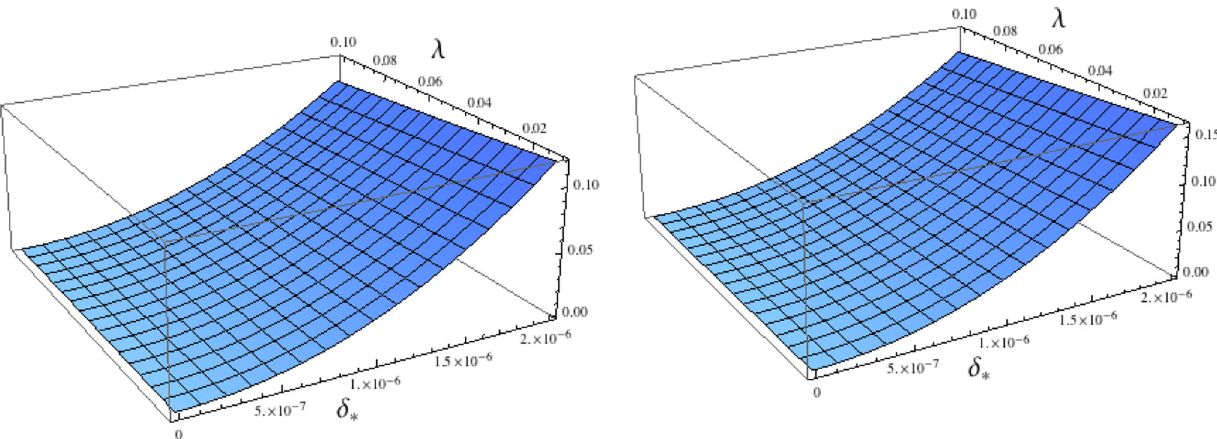
Fig. 9 Figures show the behavior of ˜ c 1 against δ (cid:25) and λ given by Eq. (4.47). A vertical axis represents values of ˜ c 1 . For the plots we have used N = 60 (left panel) and N = 70 (right panel)